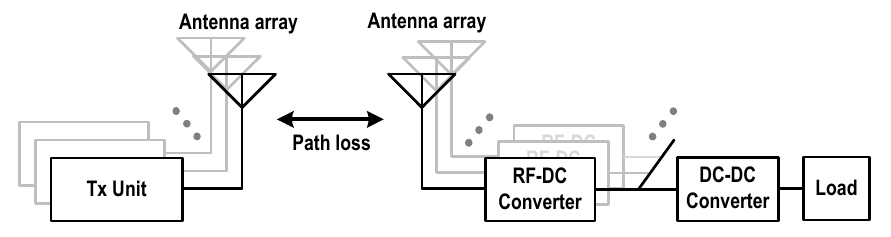
Figure 1. A block diagram of the MPT system based on massive Tx and Rx antenna